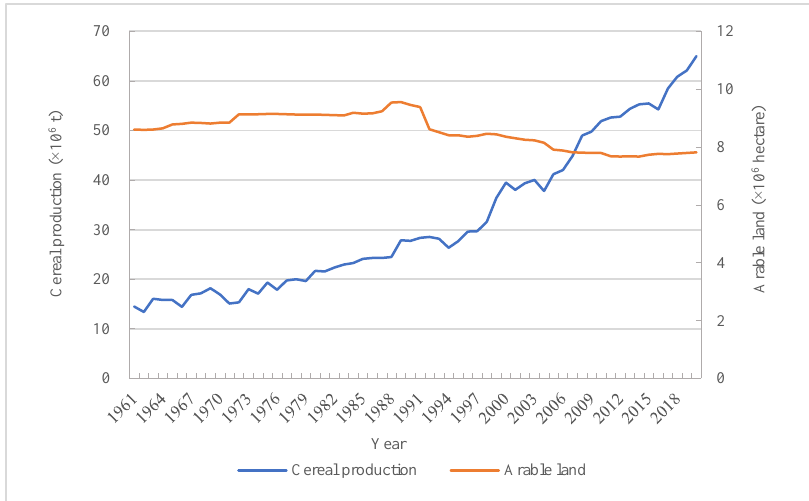
Figure 6. Change of cereal production and arable land. Table 3. Correlations between per capita food consumption and different influencing factors. Influencing Factors Correlation Coefficient ( r )